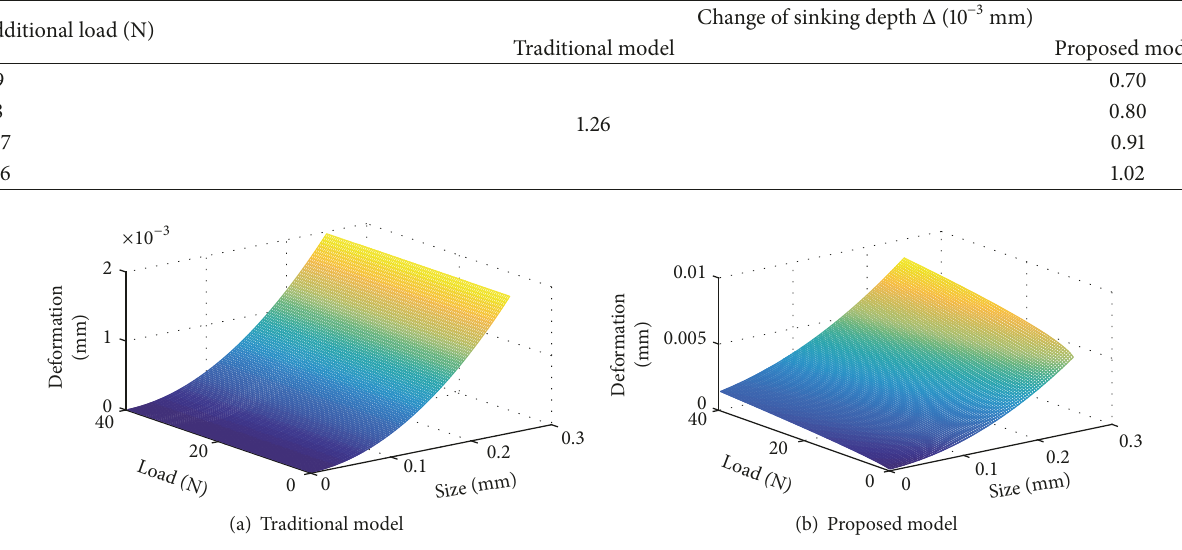
Figure 12: Maximum sinking depth of the balls at the centre of the defect.